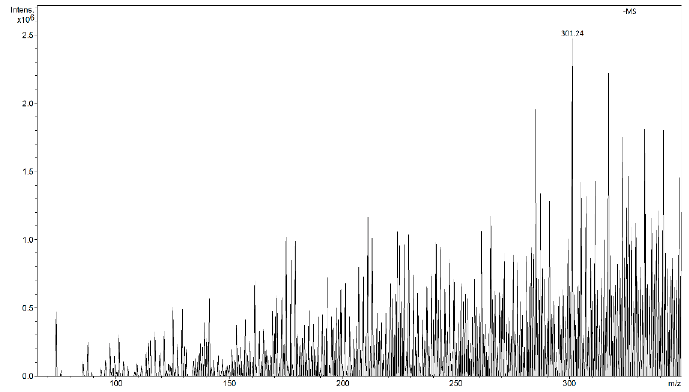
Figure 12. FAPA spectrum of Q-MIP after concentration of quercetin from solution of yellow onions ( m/z 301 [M − H] − ).